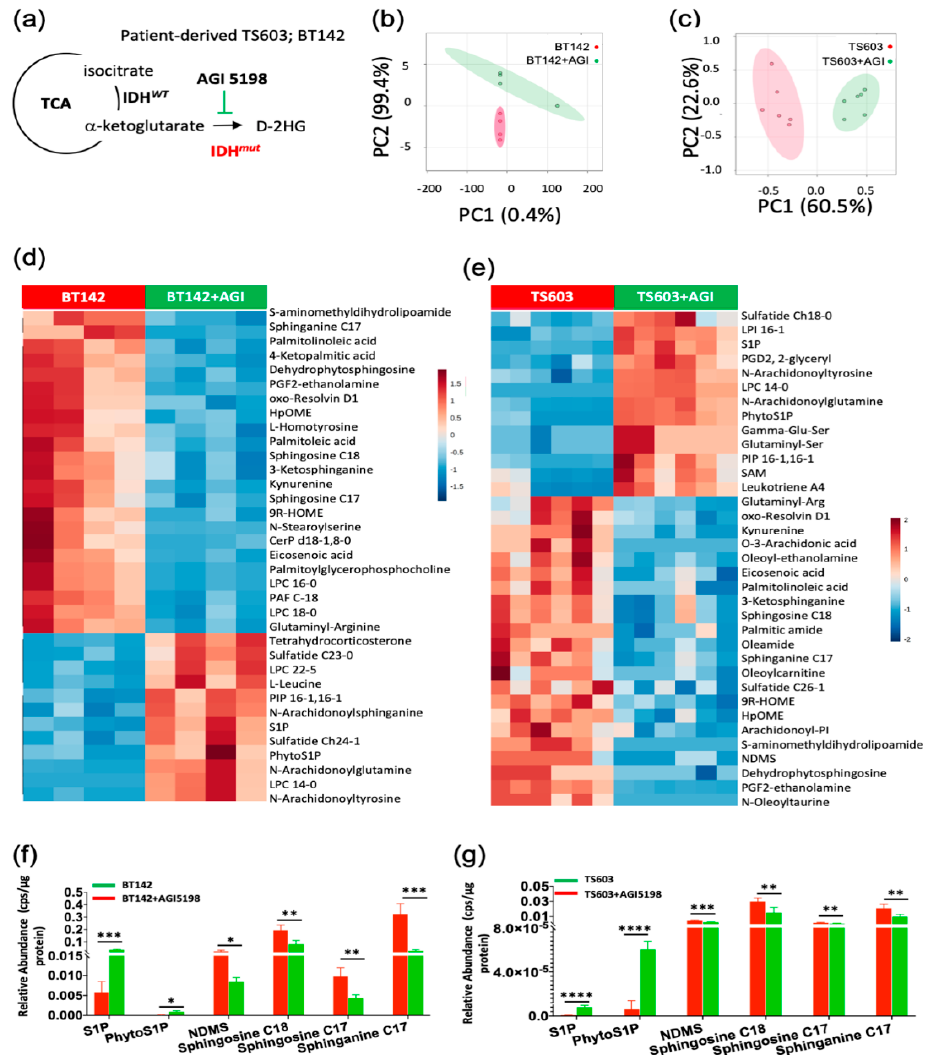
Figure 1. Discovery of sphingolipids pathway altered in response to suppression of D-2HG formation of patient-derived IDH1 mut cell lines ( a ). Schematic representation of the reaction catalyzed by IDH1 mut prevalent in glioma and the strategy utilized in this manuscript. BT142 and TS603 are cell lines derived from either astrocytoma or oligodendroglioma patients respectively and were treated with 50 µM AGI5198 to probe common metabolic alterations associated to inhibition of IDH1 mut activity in both cell lines. ( b ) 2D PCA plot for the untreated BT142 (red) and AGI5198-treated cells (green) ( n = 4). ( c ) 2D PCA plot for the untreated TS603 spheroids ( n = 6) (red) and AGI5198-treated (green) TS603 cells ( n = 6). ( d , e ), heatmaps displaying differentially regulated lipids in IDH1 mut control (red) versus AGI 5198-treated cells (green). Heatmaps were generated using MetaboAnalyst 4.0 [23]. ( f , g ), bar plots of sphingolipids that displayed the same trend upon AGI-5198 treatment (green) in both cell lines. Statistical analysis (t-test) was conducted assuming equal variance, p -values are represented as follows: **** p < 0.00005, *** p < 0.0005; ** p < 0.005; * p < 0.05; ns, not significant.